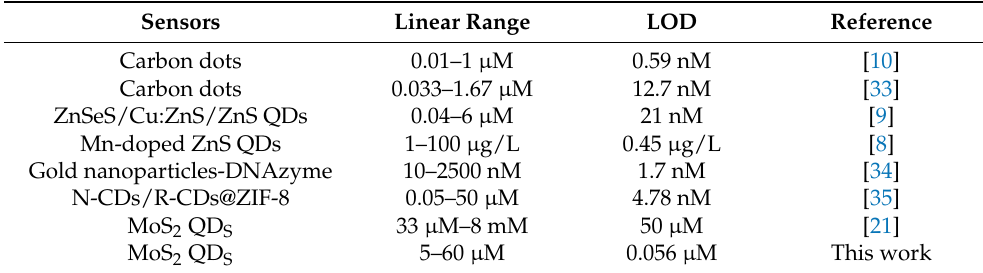
Figure 4. ( a ) Fluorescence spectra of MoS 2 QDs with different concentrations of Pb 2+ ion from 0 to 120 µ M; ( b ) linear curve between (F 0 − F)/F 0 and Pb 2+ ion concentration in the range 5 to 60 µ M. Table 1. Comparison of various fluorescent sensors for Pb 2+ ion detection.